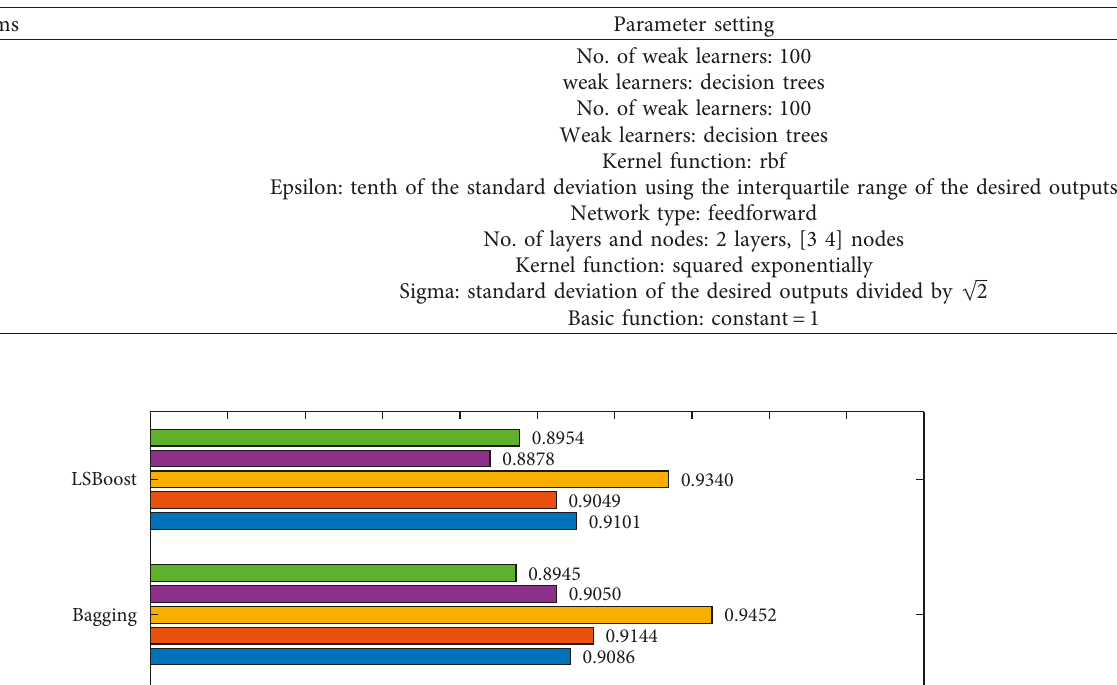
Table 2: The parameters of ML algorithms.